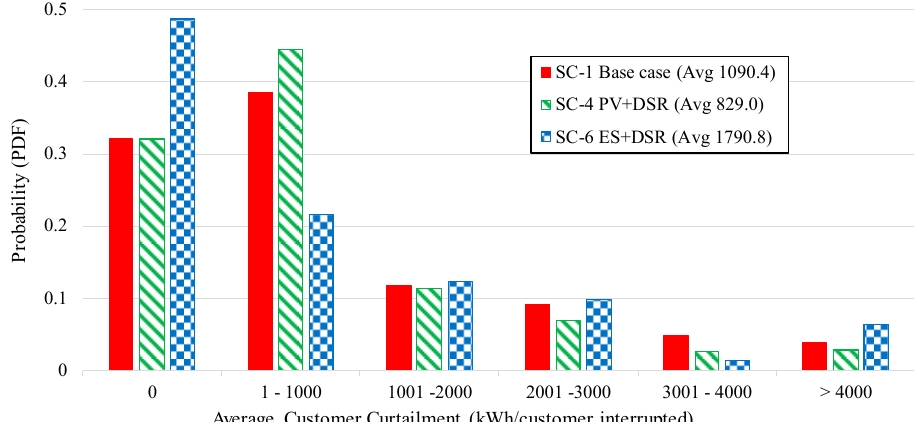
Figure 18. Comparison of PDFs for ACCI values for different scenarios.